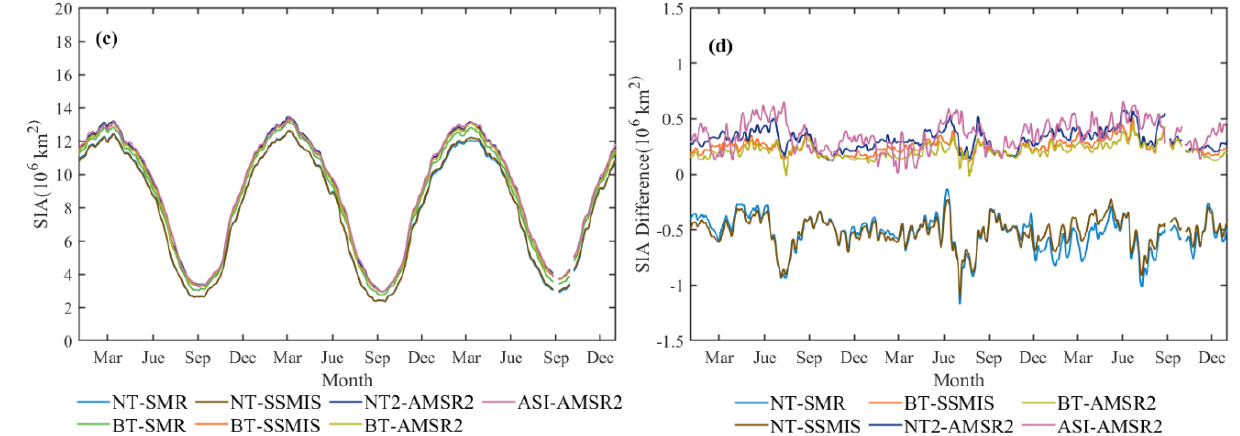
Figure 15. Arctic SIE ( a ) and SIE difference ( b ), and SIA ( c ) and SIA difference ( d ) time series from the SIC datasets used.